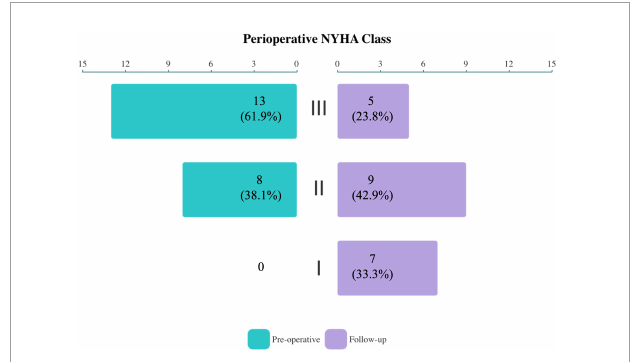
FIGURE3 Compared with baseline, the overall NYHA functional class of study population significantly improved at follow-up ( P = 0.004).